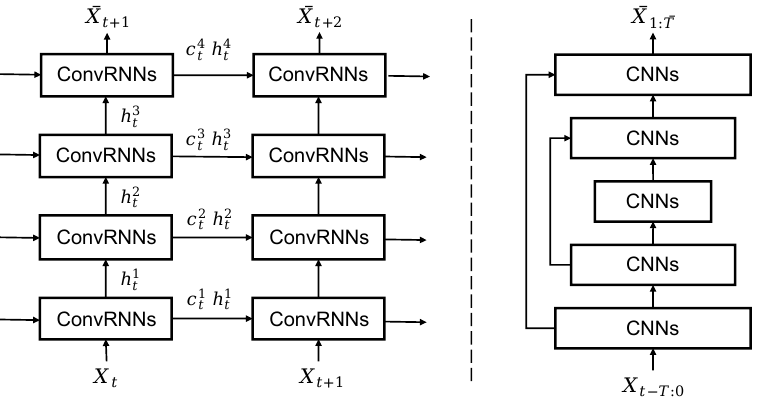
Figure 2. Left : convolution-based recurrent neural networks. Right : convolutional neural